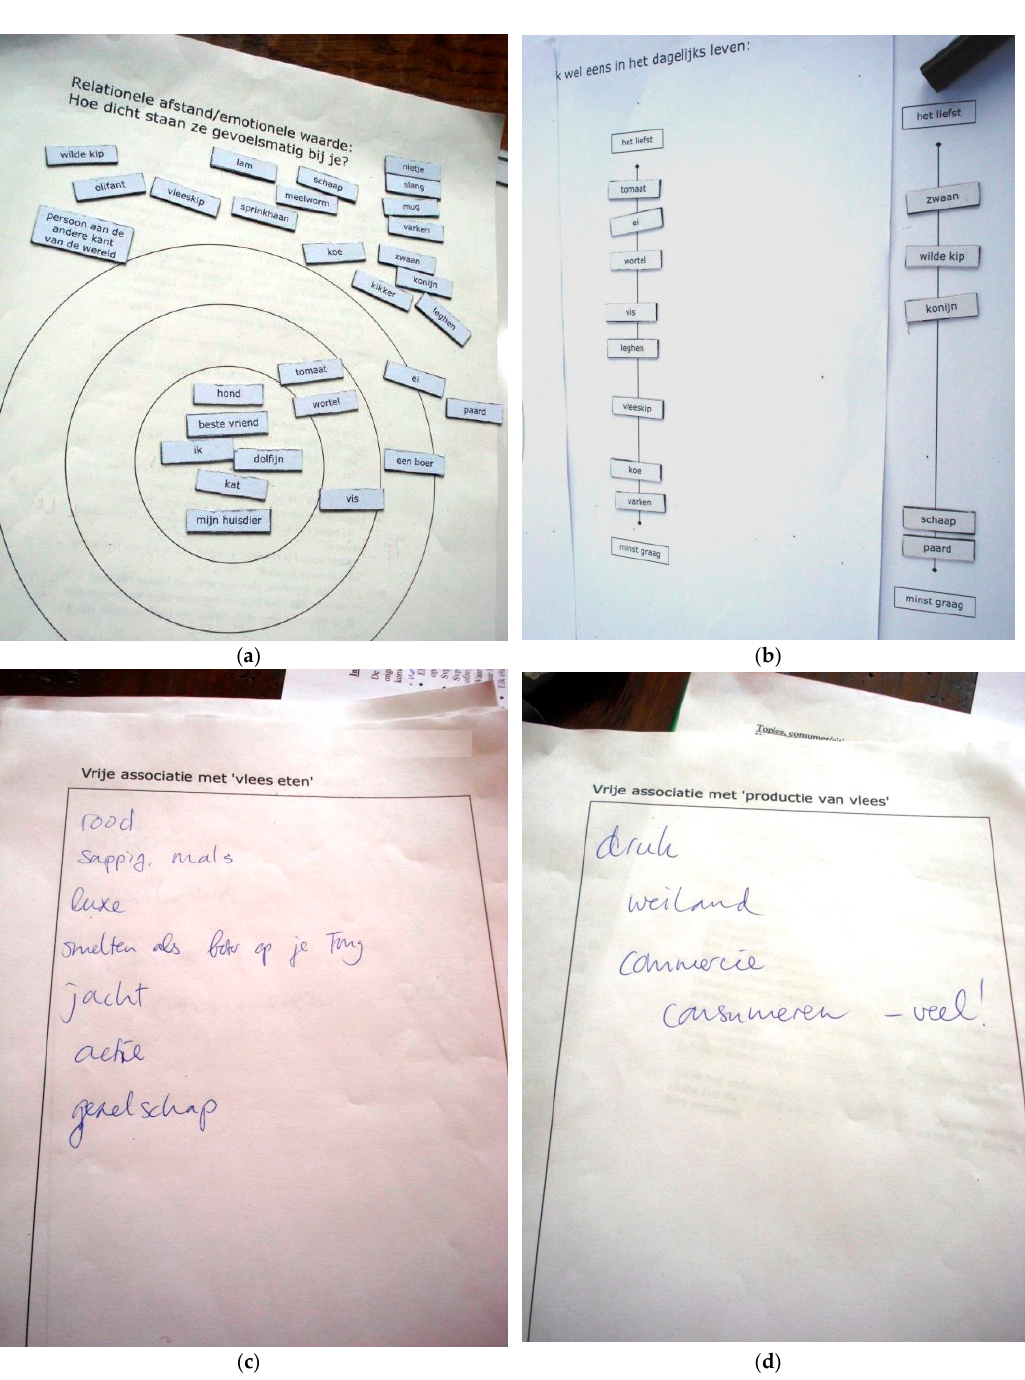
Figure 1. Example results to illustrate our visual interview techniques: ( a ) Circles of relational distance/emotional value: “How close do they feel to you?”, using the items presented in Table 1; ( b ) Lines of items eaten in daily life vs in exceptional cases; ( c ) Free-listing on the topic “eating meat” (“ Red; Juicy; Tender; Luxury; Melting on your tongue; Hunt; Action; Company ”); ( d ) Free-listing on the topic “production of meat” (“ Busy; Meadow; Commerce; Consumption—a lot! ”).